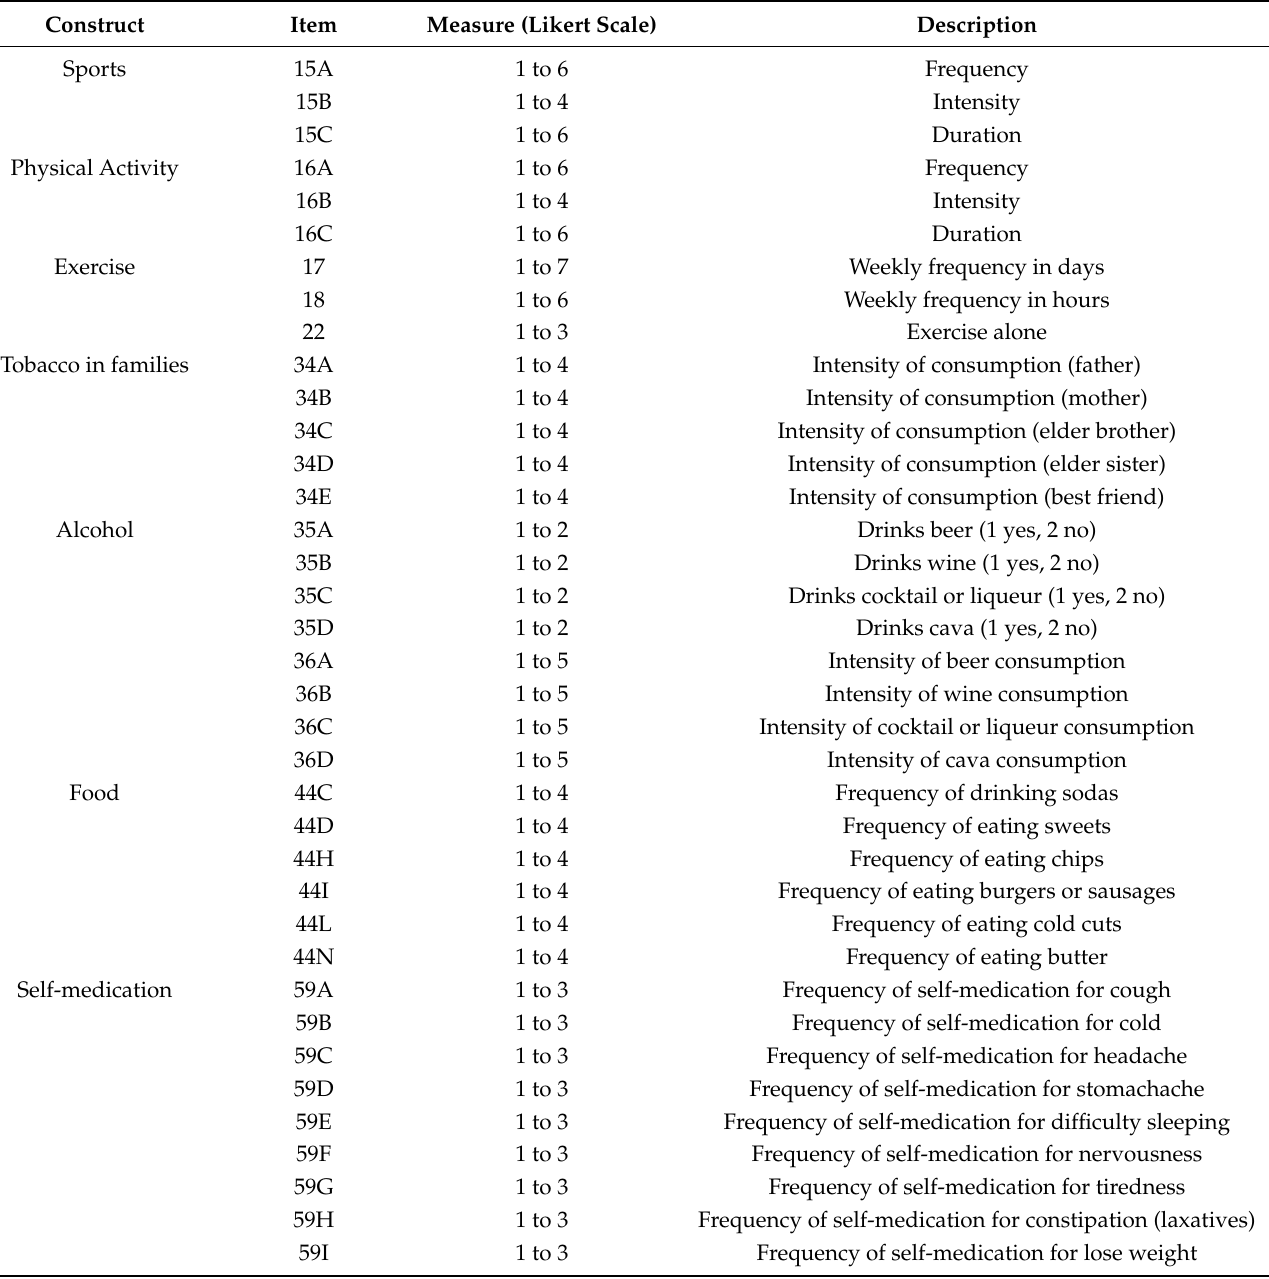
Table 1. The constructs and indicators used in this